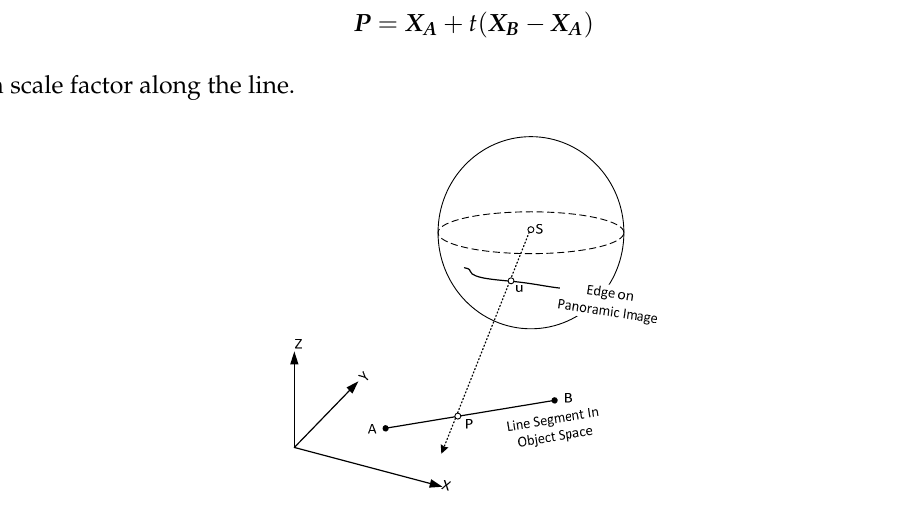
Figure 7. Line-based transformation model on panoramic image.